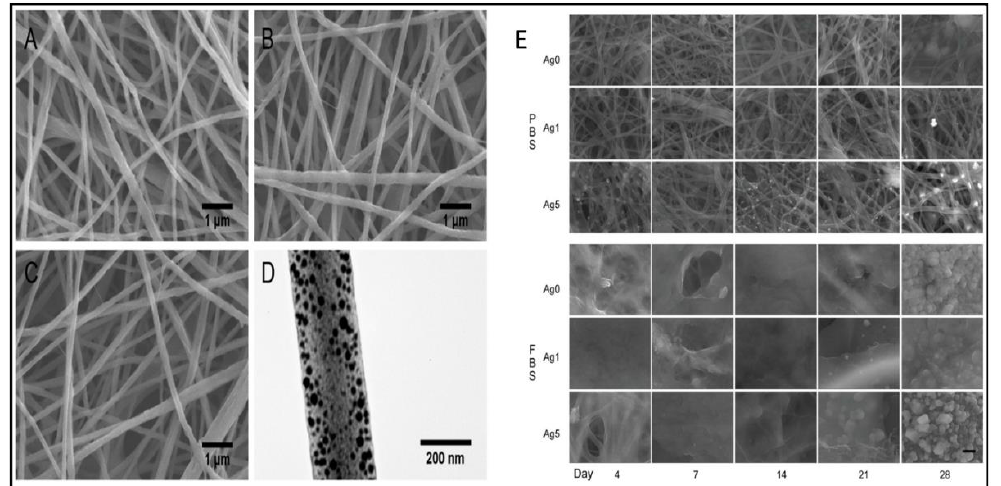
Figure 14. The SEM images of the electrospun membranes of ( A ) Ag0, ( B ) Ag1, and ( C ) Ag5 groups. ( D ) The TEM image of a single fiber from the Ag5 group, where the electron-dense areas were silver nanoparticles. In vitro interaction with PBS and FBS. ( E ) The SEM micro-images of membranes after being immersed in PBS and FBS. Scale bar: 1 μm; images reproduced with permission from [147] © 2019 Materials Science & Engineering C. Published by Elsevier Ltd.